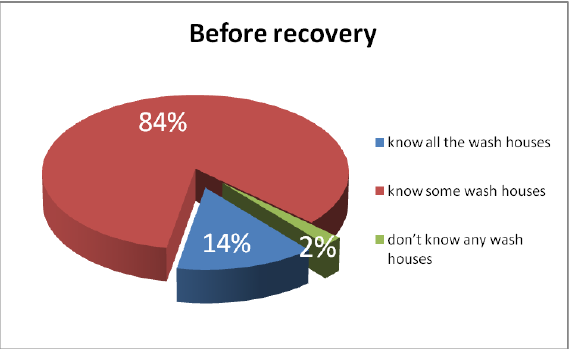
Figure 1. Survey on the knowledge of the wash houses before recovery among population under fifty.